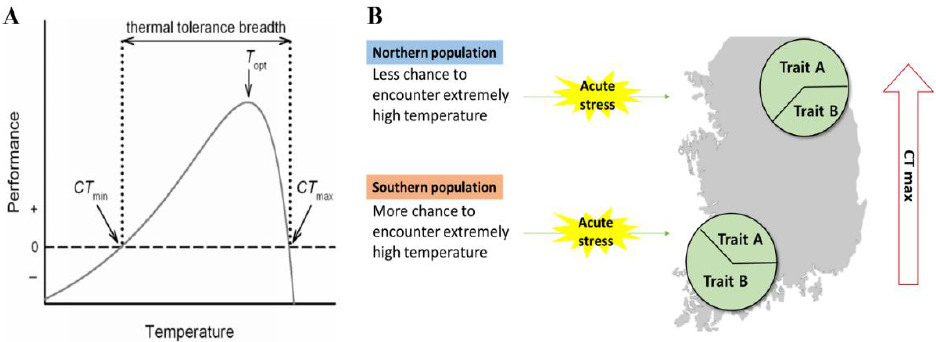
Figure 1. Relationship between temperature and performance in ectotherms and heat shock protein- dependent thermal responses. ( A ) Typical relationship between body temperature and performance in ectotherms is a left-skewed Gaussian distribution limited by lower thermal tolerance and upper thermal tolerance. ( B ) Trait A: heat shock protein-dependent thermal response, trait B: heat shock protein-repression thermal response.